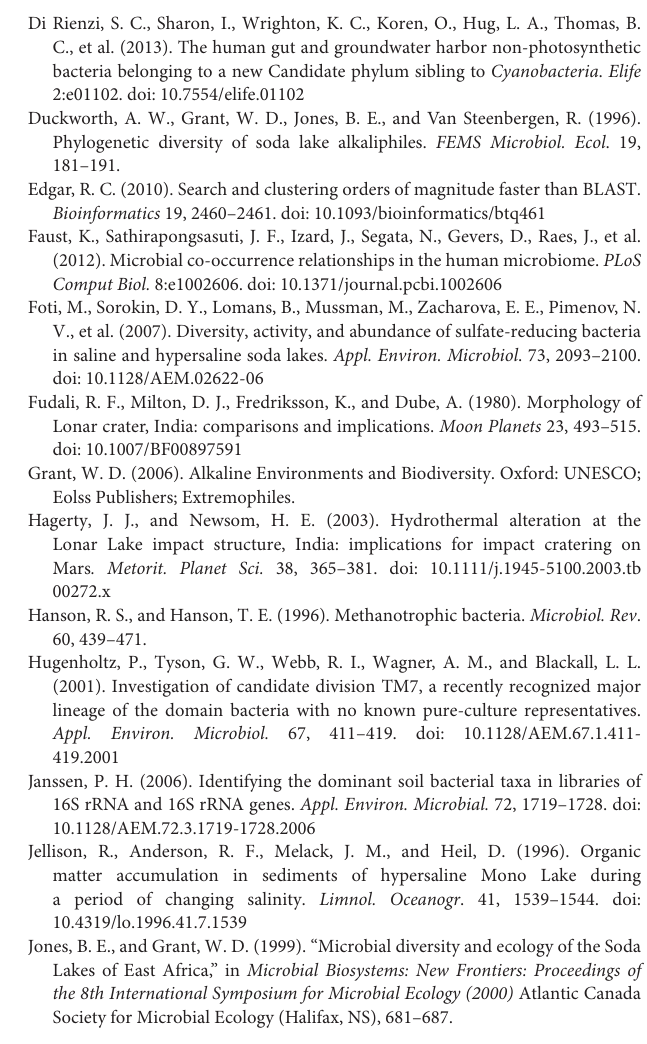
Supplementary Table1 | Details of the primers